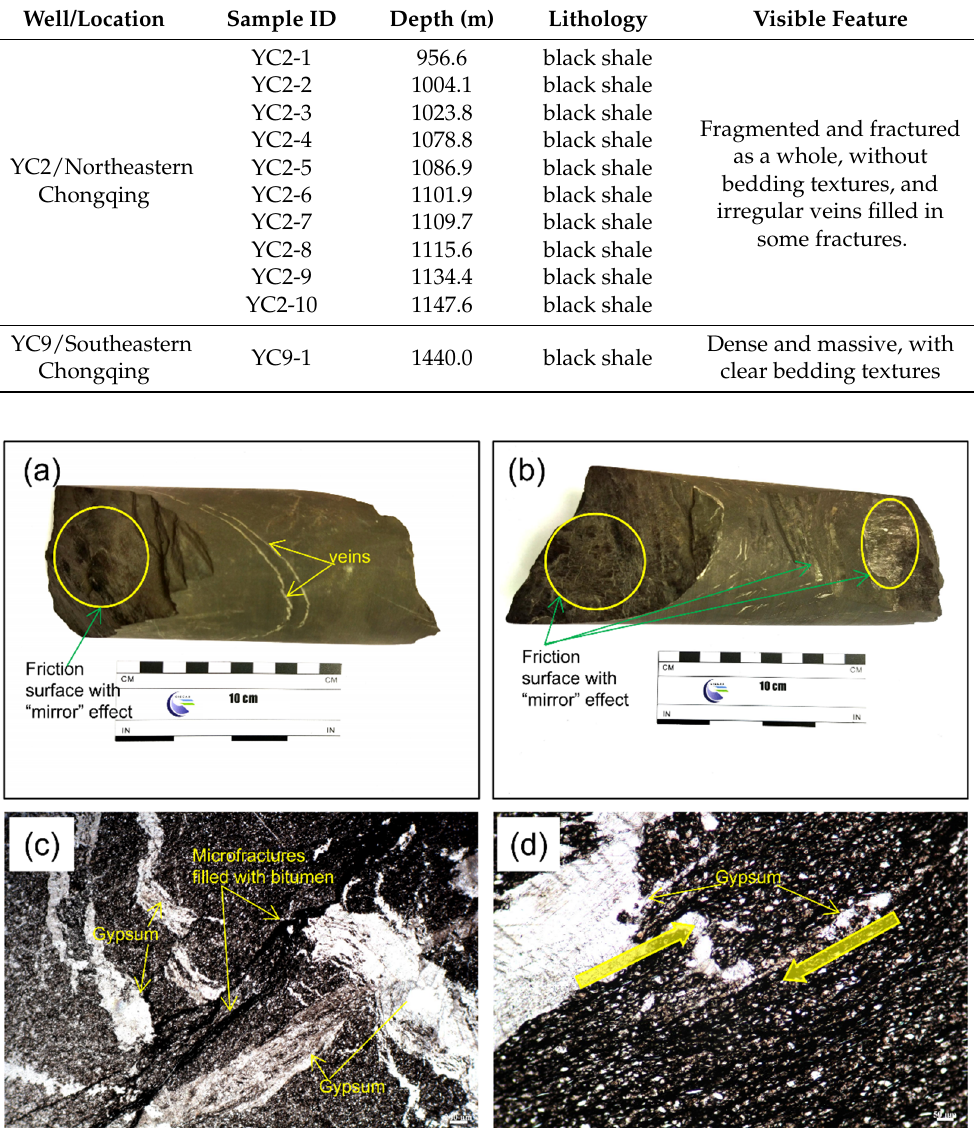
Figure 2. ( a ) A photograph of the core sample of YC2-3, showing visible friction surfaces with a mirror effect caused by structural friction. ( b ) A photograph of the core sample of YC2-4, with multiple slippage surfaces and unrecognizable bedding textures. ( c ) A microscopic photograph of sample YC2-6 (thin section, single polarized light), showing multiple veins composed of gypsum and a fault cutting through the veins that indicates at least one phase of stress action. ( d ) A photograph of sample YC2-9 (thin section, single polarized light), showing gypsum veins and surrounding mineral matrix with an obvious deformation.